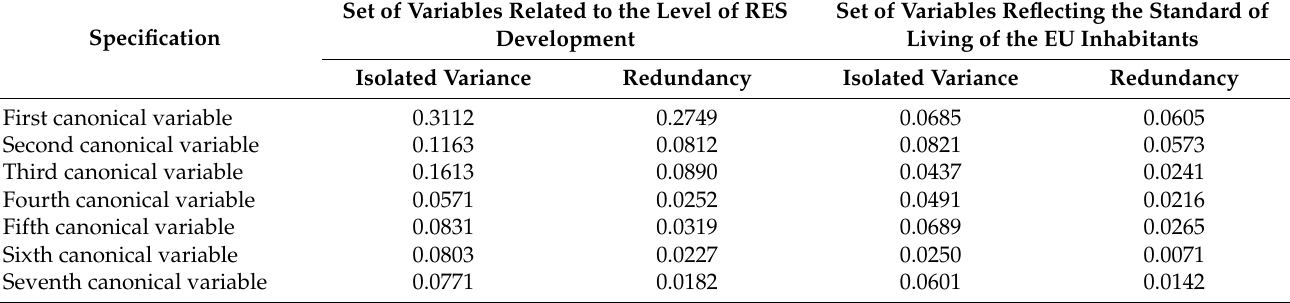
Table 7. Isolated variances and